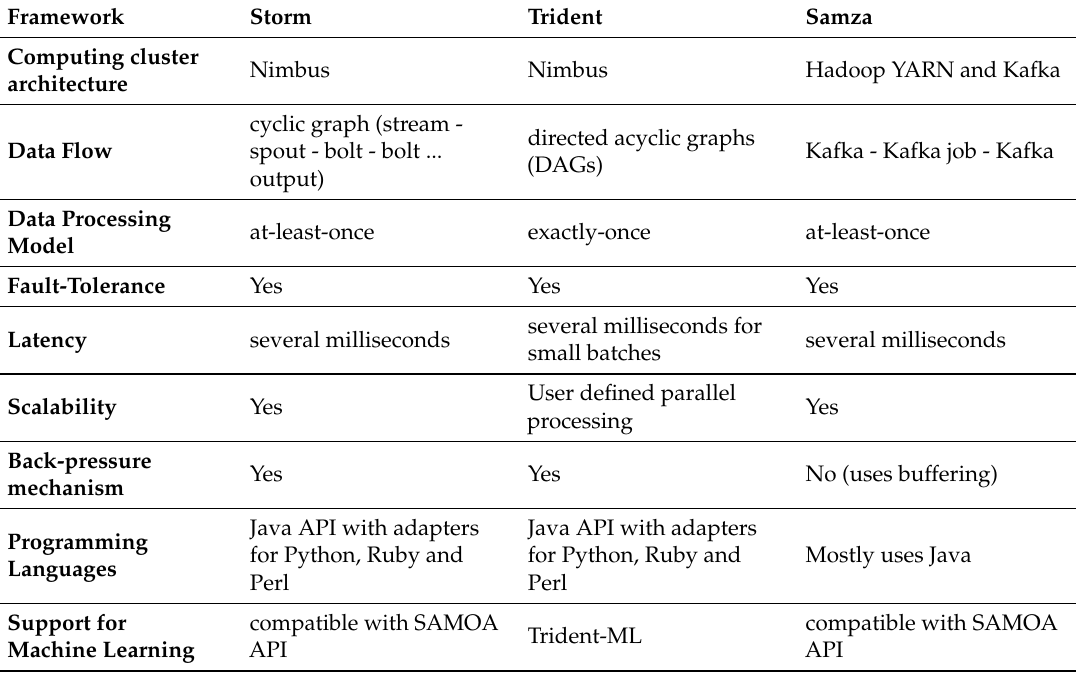
Table 2. Comparison of stream processing